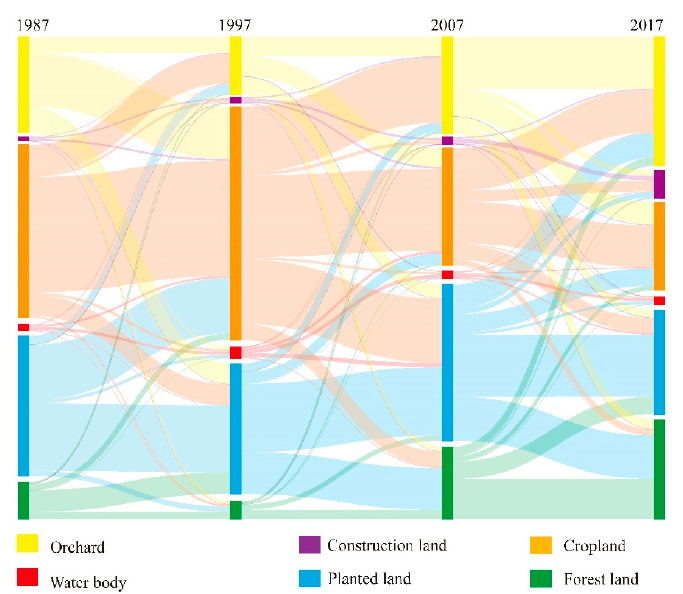
width of the lines represents the transfer areas of land use/cover